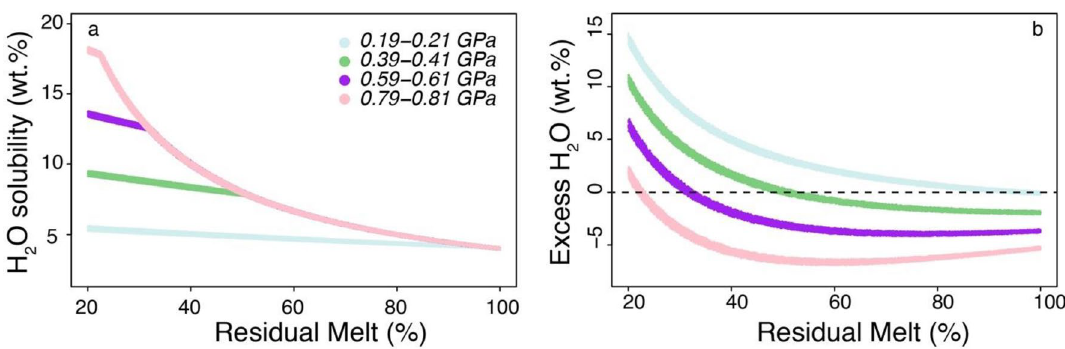
Figure 8. Variations of H 2 O solubility ( a ) and excess H 2 O ( b ) with changing residual melt fraction at 4 different pressures of magma fractionation (see Supplementary Note 2 in Supplementary Information). The starting H 2 O content at all pressures is 3.9–4.1 wt% and the H 2 O is considered to behave as completely incompatible. The pressure and melt composition dependency of H 2 O solubility in silicate melts are from the parametrization of ref. 59 based on the model of ref. 52 . The different curves are the result of > 1000 simulations for ranges of initial H 2 O content of 3.9–4.1 wt% and pressures ranges of 0.19–0.21, 0.39–0.41, 0.59–0.61 and 0.79–0.81 GPa. The kinks of the curves in ( a ) indicate the point at which H2O saturation occurs (i.e., when on the right hand plot the curves raise above 0 wt% excess H 2 O). In Fig. 8b negative values indicate H 2 O-undersaturated conditions whereas positive ones indicate H RStudio interface of the R software 33